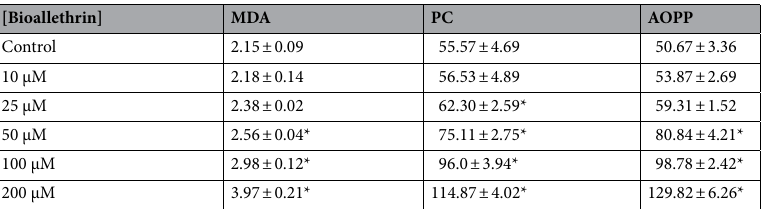
Table 1. Effect of bioallethrin on oxidation of lipids and proteins. All parameters were determined in cell lysates. MDA concentration is in μmoles/mg protein while PC and AOPP are in nmoles/mg protein. Lymphocytes were incubated with bioallethrin for 2 h at 37 °C. Results are ± standard deviation of six different samples. MDA malondialdehyde; PC protein carbonyls; AOPP advanced oxidation protein products. *Significantly different from control at p < 0.05.